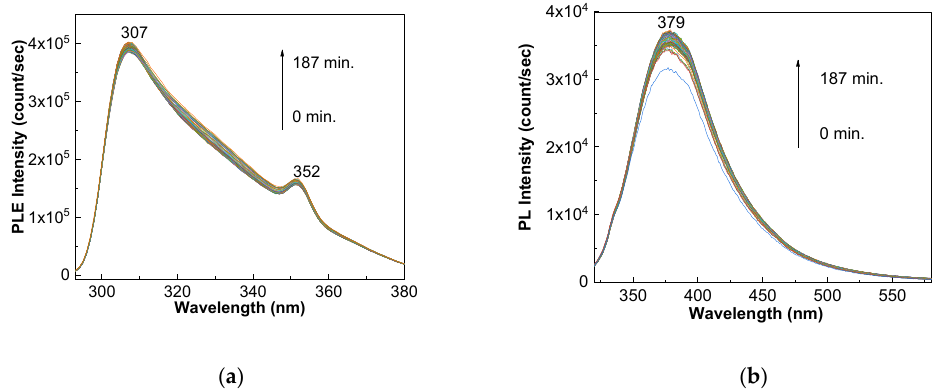
Figure 5. PLE ( a ) and PL ( b ) spectra of the LP aqueous solution, under UV light exposure for 187 min. Figure 6a,b highlights the PLE and PL spectra of LO when in dark conditions. From